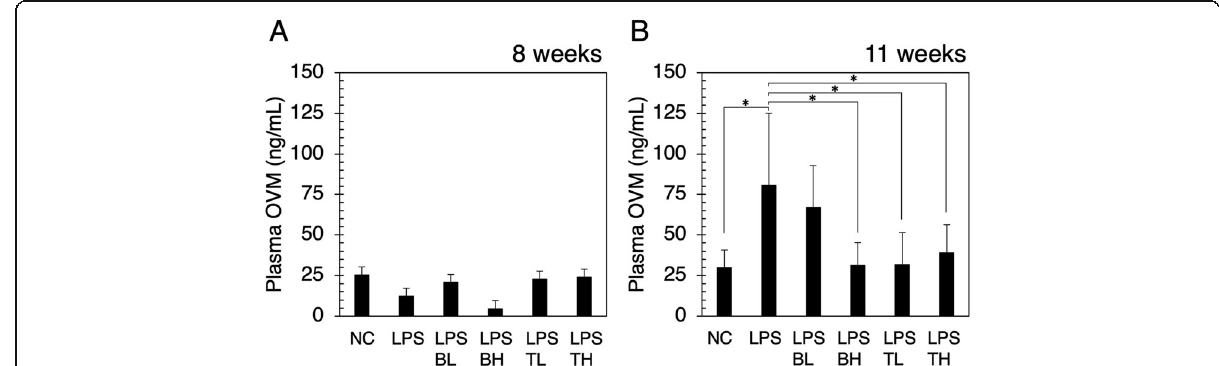
Fig. 2 Detection of plasma OVM after OVM gavage. Mice in OVM group were force fed 0.2 mL the FITC-labelled OVM (adjusted to 2.5 mg/ mouse), 2 h later blood was collected from saphenous vein at 8 weeks ( a ) and 11 weeks ( b ) (n = 6). FITC-labelled OVM in plasma was precipitated in 50% ammonium sulfate and redissolved in water. Fluorescent intensity of sample was measured using fluorescence microplate reader.